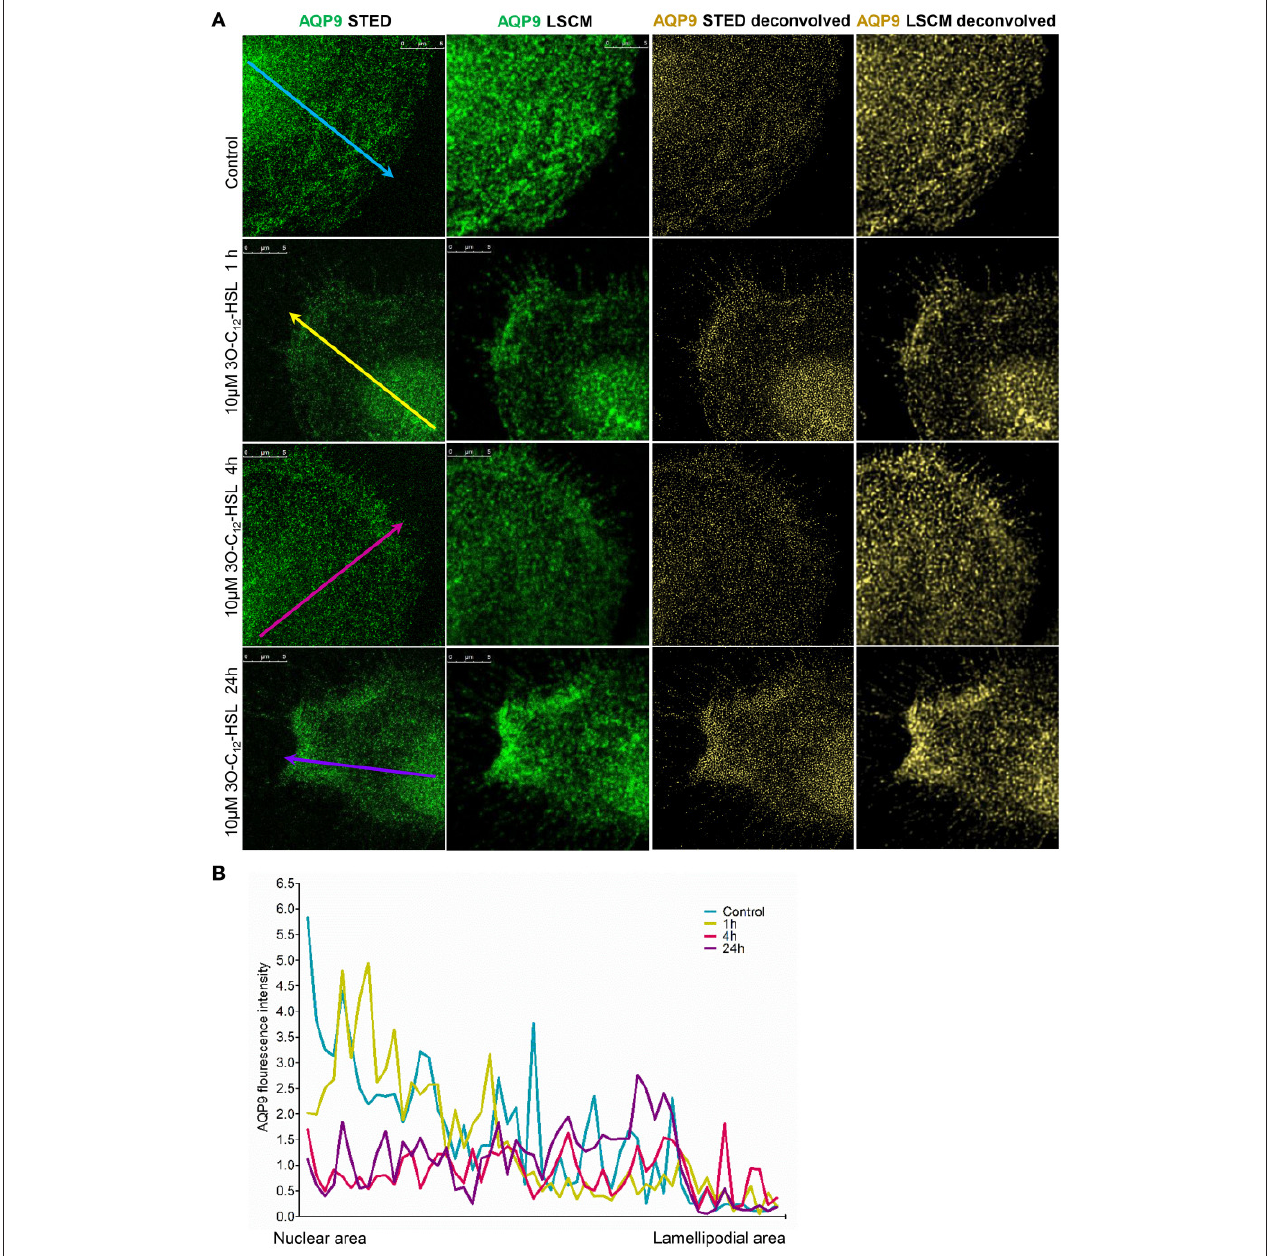
FIGURE 7 | Nanoscale imaging of AQP9 architecture in 3O-C 12 -HSL-stimulated macrophages. (A) Macrophages were stimulated with 10 µ M 3O-C 12 -HSL for 1, 4 or 24h, or 0.02% DMSO as a vehicle control (Control), stained for AQP9 (green) and analyzed with STED nanoscopy. The two left panels show the images after Huygens deconvolution (gold) with improved visualization quality. Bar 5 µ m. (B) AQP9 fluorescence intensity profiles over the cells, measured as indicated by colored arrows in (A) in the direction from nuclear to lamellipodial area on the representative